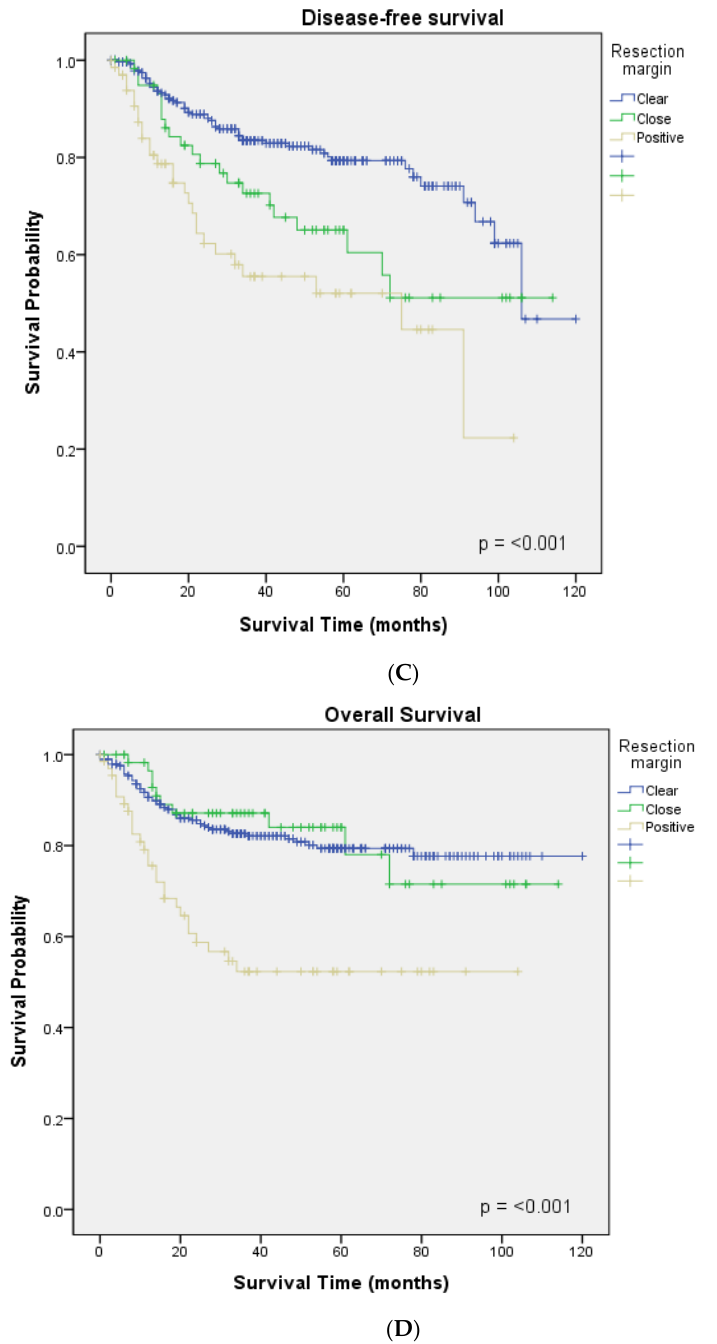
Figure 1. Kaplan–Meier curves of the survival outcomes of oral/oropharyngeal cancer patients ( n = 418). ( A ) Disease-free survival, ( B ) overall survival, ( C ) disease-free survival by the surgical margin, and ( D ) overall survival by the surgical margin.